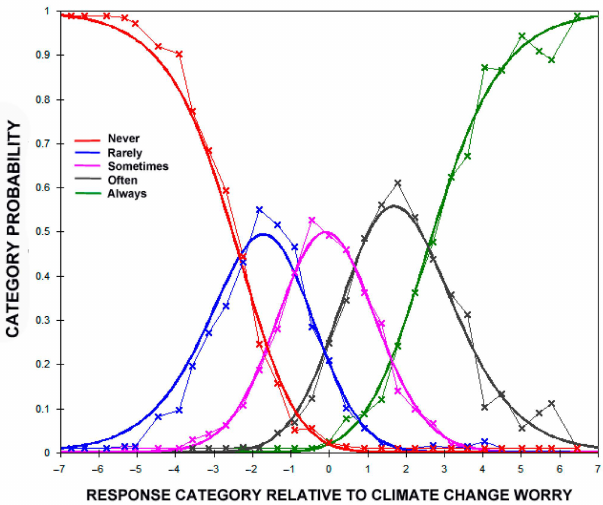
Figure 1. Actual and modeled proportion of responses within each response category. Note: x represents data and smooth lines represent the Rasch model.